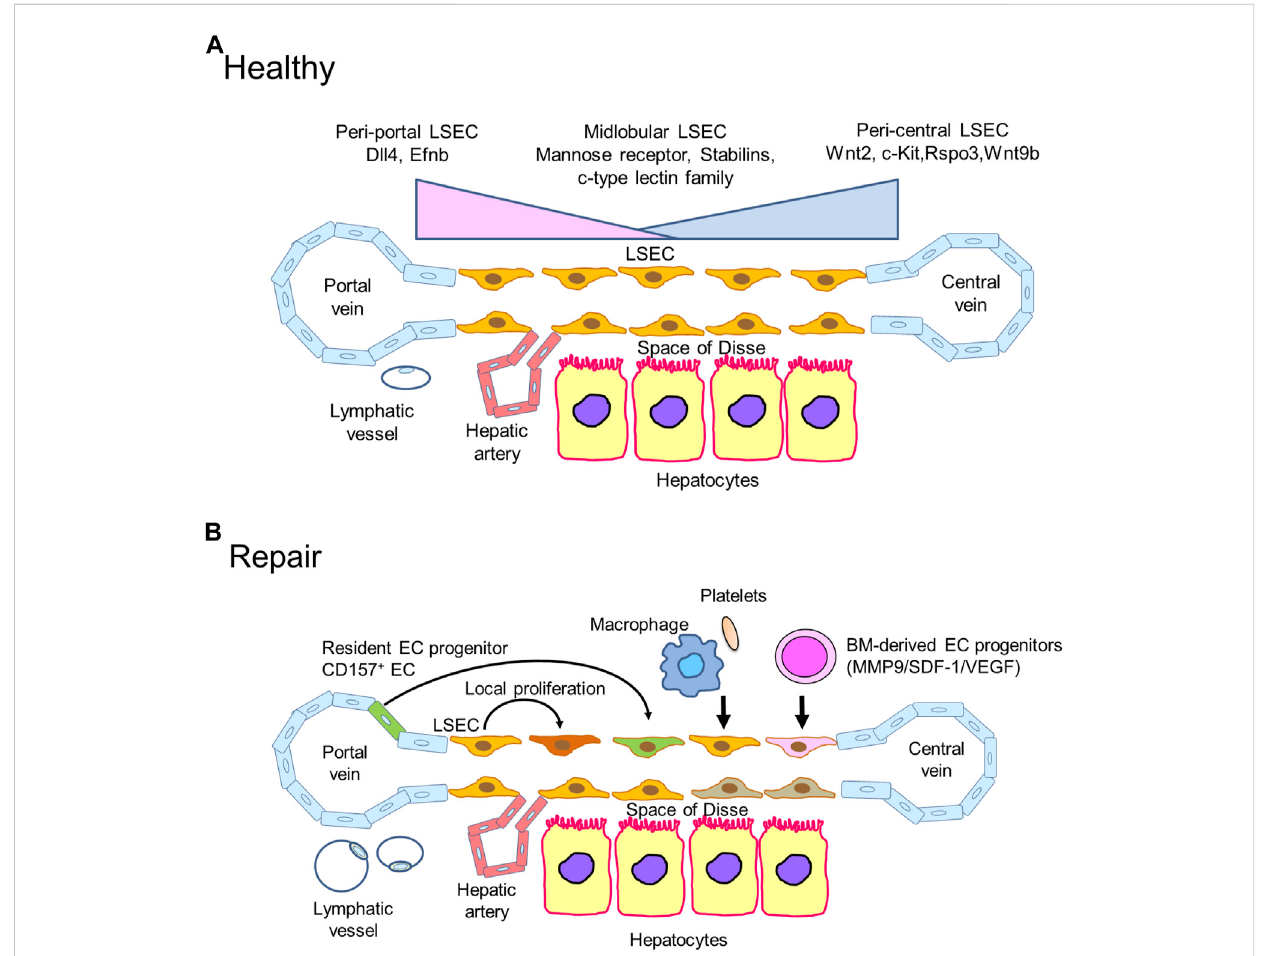
FIGURE 2 Liver sinusoidal endothelial cells (LSECs) in liver repair (A) . Zonation of LSECs. LSECs secrete speci fi c angiocrine factors in a zonation-speci fi c manner from the portal vein to the central vein. Peri-central LSECs modulate the spatial division of hepatocytes by secreting angiocrine Wnt ligands and Wnt-signalingenhancerRSPO3.Hepaticlymphatic fl uids mainlydraininto thelymphaticvesselsintheportaltract. (B) . During acuteliverinjury,including liver IRI, damaged LSECs are restored and re-renewed through different mechanisms. The proliferation of remaining neighboring LSECs replaces lost LSECs by producing angiocrine factors, including hepatocyte growth factor (HGF), Wnt, and stem cell factor (SCF). Accumulated reparative macrophagesandplateletsparticipateinrestoringLSECsintheinjuredareabyreleasingLSECgrowthfactors.BM-derivedECprogenitorsarerecruitedto repairdamagedLSECs throughthestromalcell-derivedfactor-1 (SDF-1)/CXCR7 axis. Additionally, resident EC progenitors expressingCD157adjacent to theportal veincontribute to LSEC regeneration after severe LSEC damage. The formation oflymphatic vessels aroundthe portal tractin response to liver IRI promotes liver repair by clearing necrotic tissue